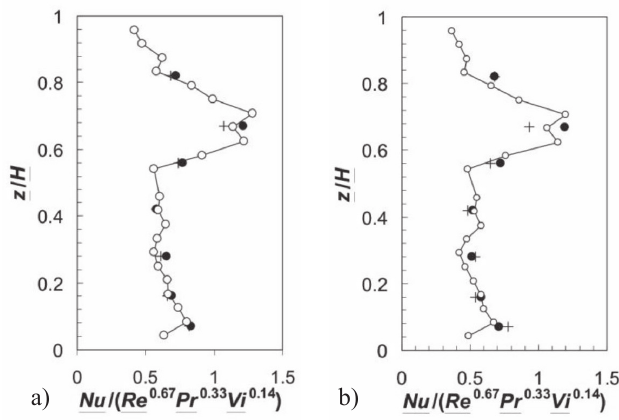
Fig. 10 – Comparison of axial distributions of the depen­ dance Nu/(Re 0.67 Pr 0.33 Vi 0.14 ) = f(z/H) for different liquids; A 315 (lower) – RT (upper); a) w = 0; b) w = 5.1 · 10 –3 m s –1 ;  og og – distilled water;  – electrolyte; + – 30 % aqueous solution of glucose; points – thermal method; solid line – electrochemi­ cal